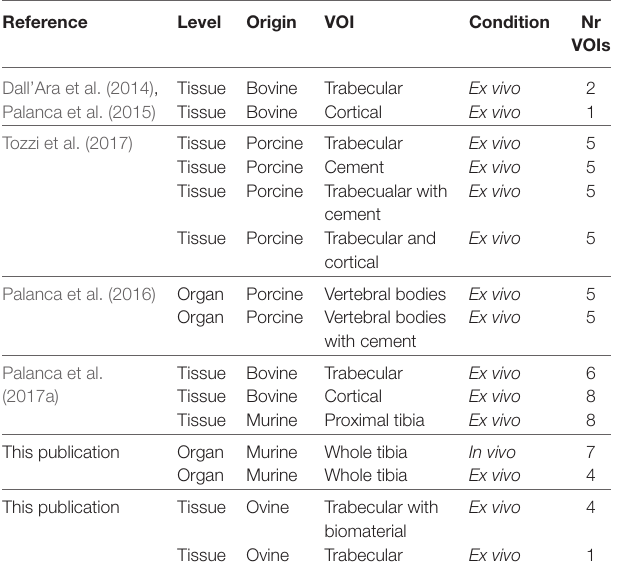
TaBle 1 | Summary of the information about the studies, the results of which are reported in this manuscript for different dimensional levels, origins of the bones, volume of interest (VOI), scanning condition, and the total number of volumes of interest (VOIs) where the measurements were performed (Nr VOIs). reference level